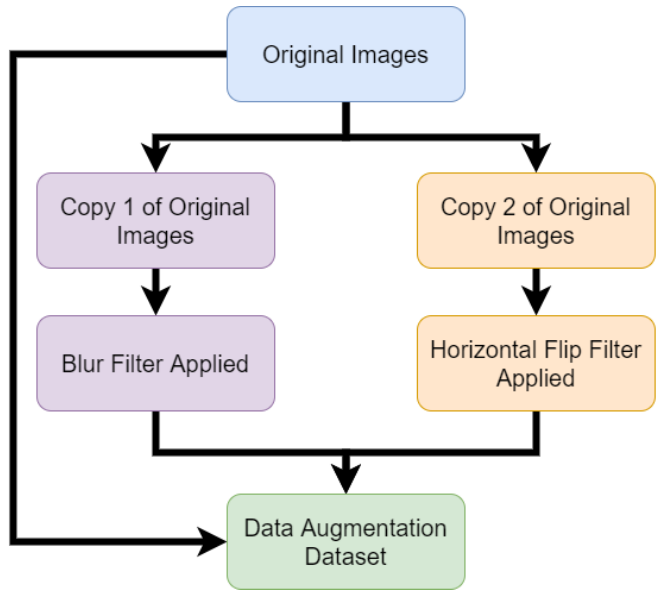
Figure 2. Flow graph of how data augmentation dataset was